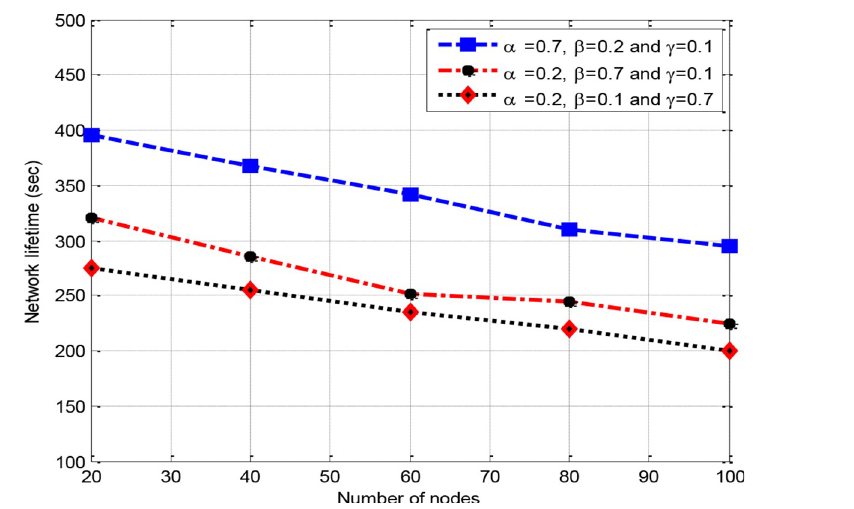
Fig 5. The impact of a number of nodes on network lifetime.